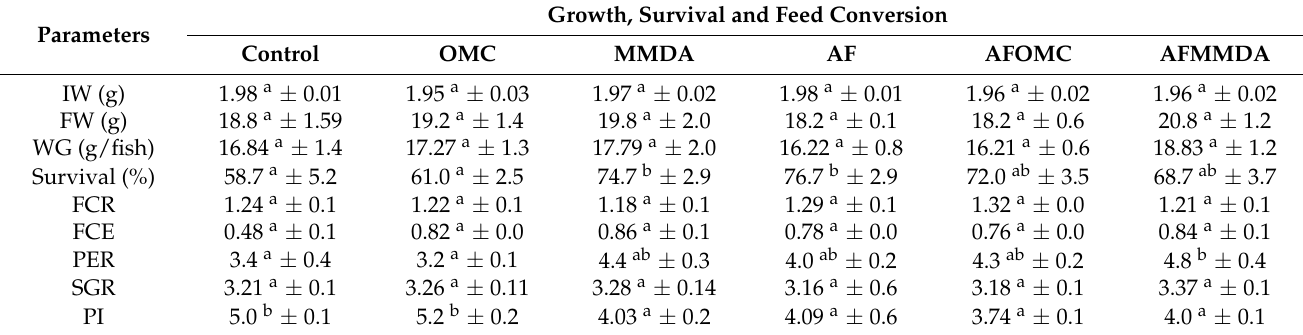
Table 2. Growth, survival, and feed conversion of Nile